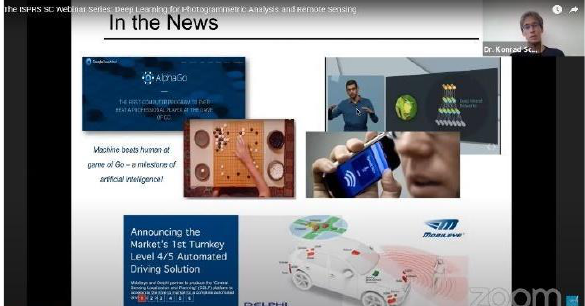
Figure 3 . Dr. Konrad Schindler of ETH Zürich for the Webinar Series, presenting his lecture titled, "Deep Learning for Photogrammetric Analysis and Remote Sensing.”